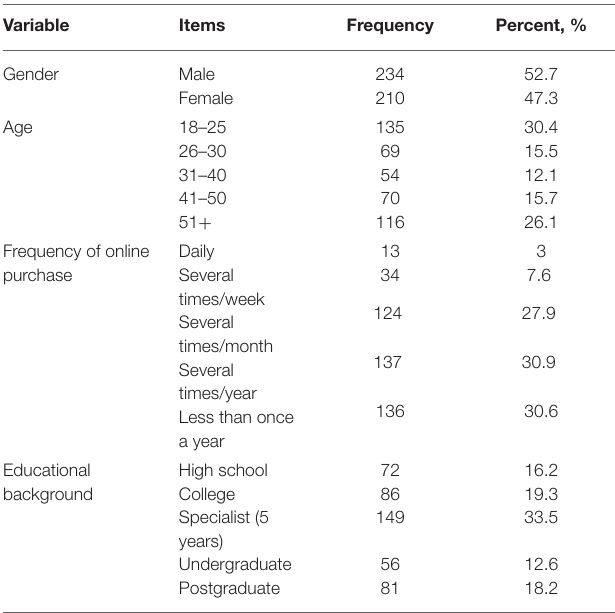
TABLE 1 | Descriptive statistics. TABLE 2 | Model